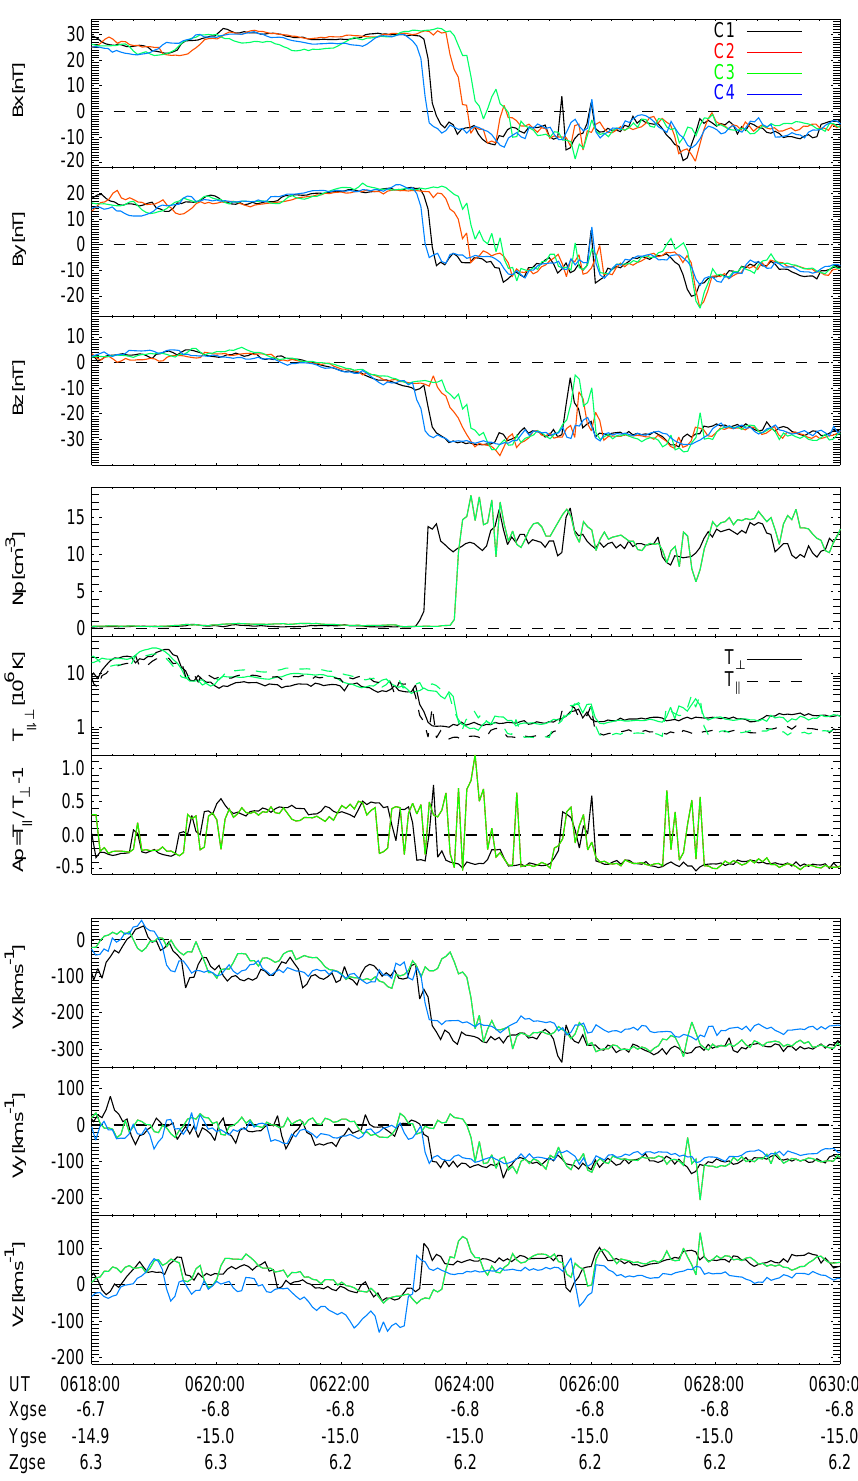
Fig. 1. Time plots of prime-parameter quantities measured by Cluster spacecraft (C1–C4) at the magnetopause on 5 July 2001, 06:18–06:30 UT. Top three panels: GSE magnetic field components from FGM experiments. Middle three panels: plasma density N p , temperatures T k and T ⊥ , and anisotropy factor A p = (T k /T ⊥ − 1 ) from CIS/HIA experiments. Bottom three panels: GSE plasma velocity components from CIS/HIA (C1 and C3) and CIS/CODIF (C4). Color code: black=C1; red=C2; green=C3;